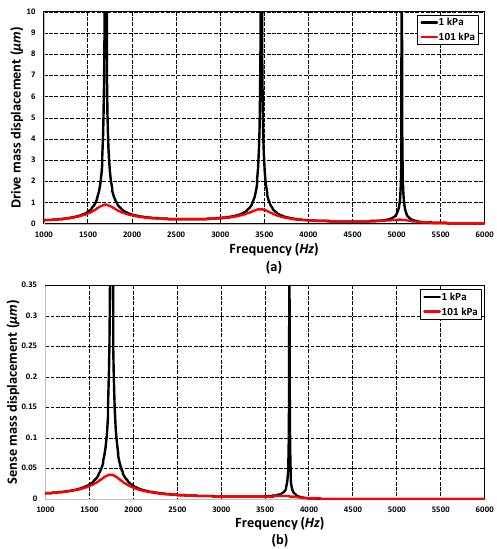
Figure 13. Effect of operating temperature variations on the frequency response of ( a ) drive mass 𝑚 (cid:2871) and ( b ) sense mass 𝑚 (cid:2871)(cid:3029) .